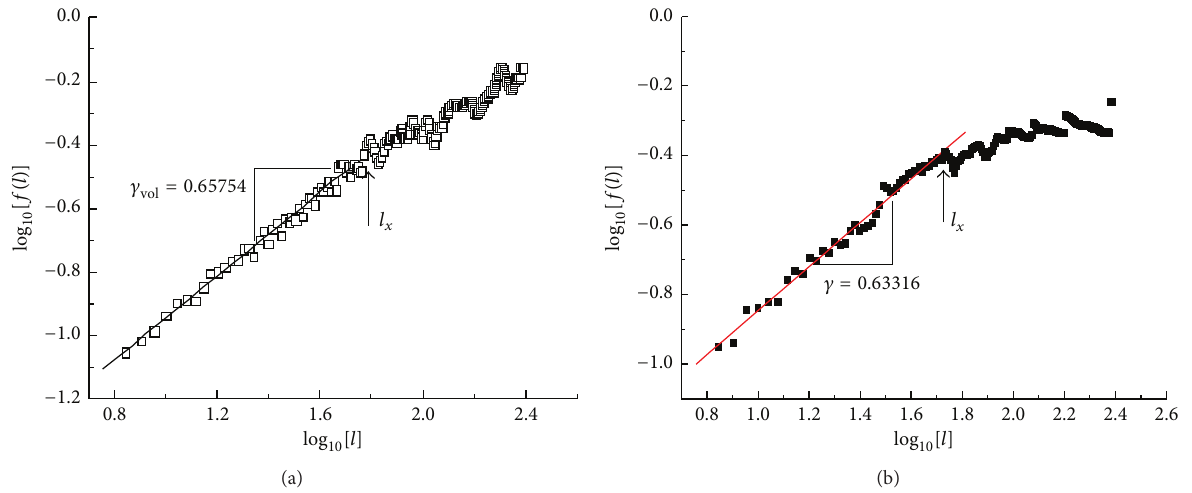
Figure 2: The DFA2 results of the tree-ring width chronology of the Huashan pines on the southern peak of the Huashan Mountains: (a) incremental sequence ( ◻ ) and (b) original sequence ( ◼ ). The straight lines represent the linear